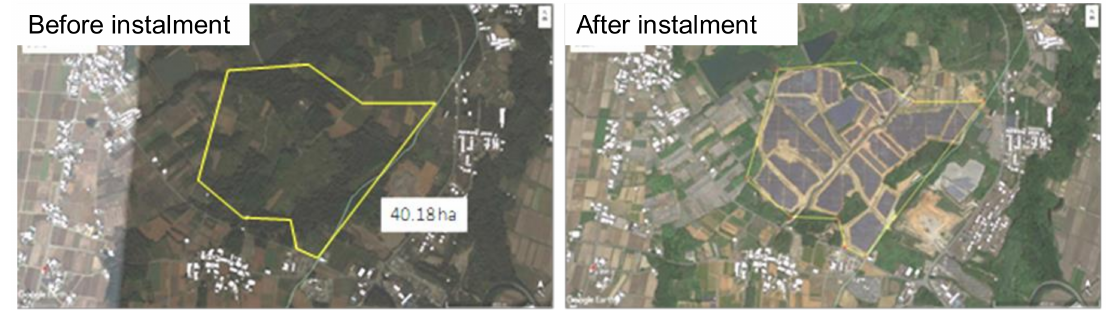
Figure 2. Satellite imagery for before ( left ) and after ( right ) installation of a collection of mega solar